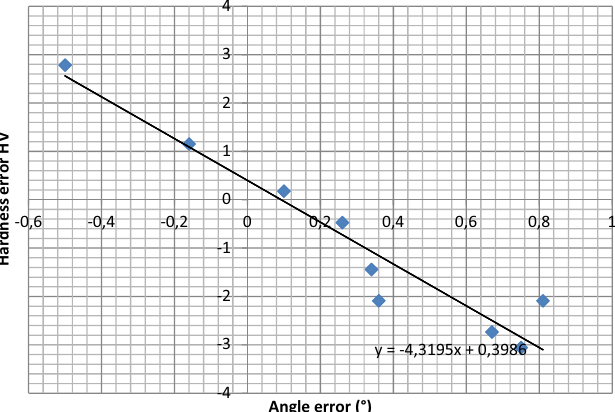
Fig. 10. (Color online) Hardness errors due to angle error. Table 4. Comparison between experimental, theoretical, and numerical analysis. Experimental Theoretical Finite element HV/( ◦ ) HV/( ◦ )